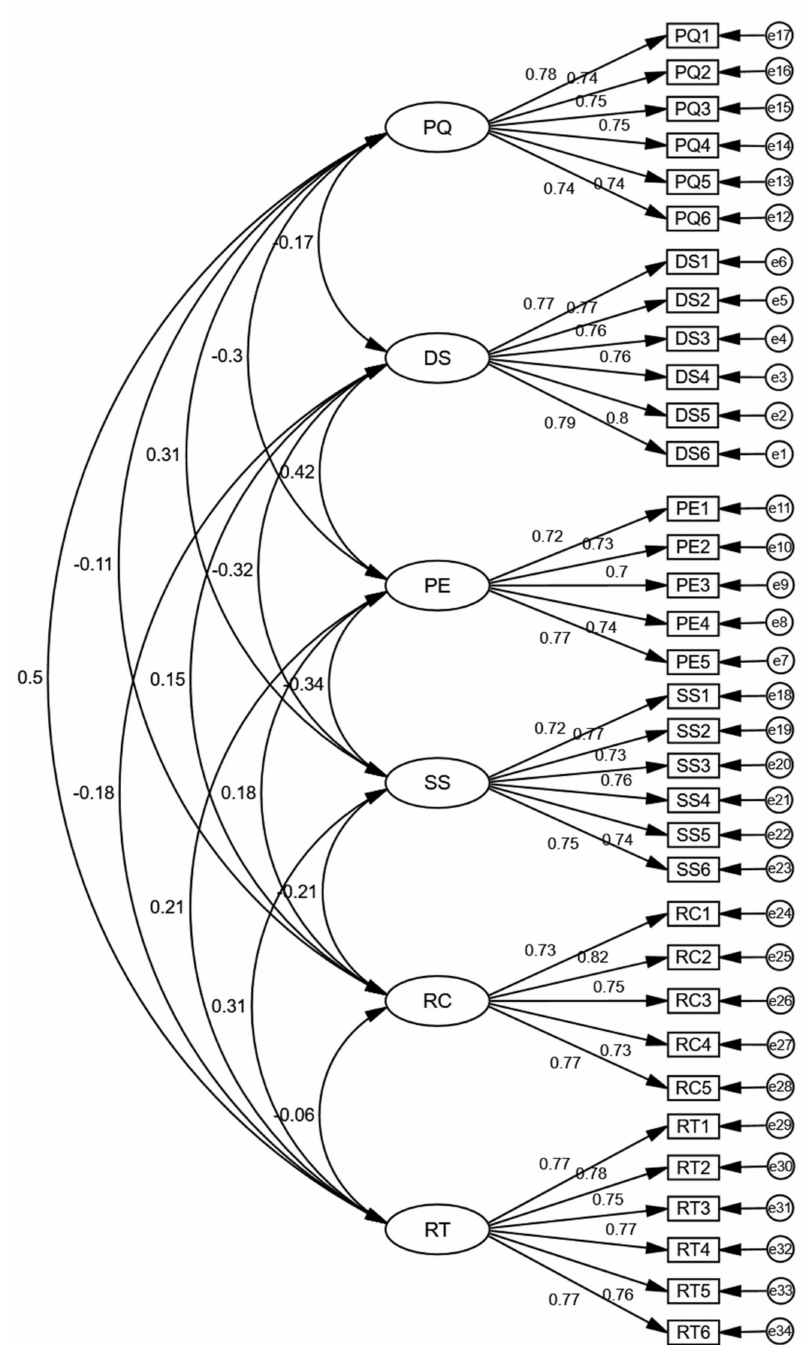
Figure A1. Parameter estimates (standardized